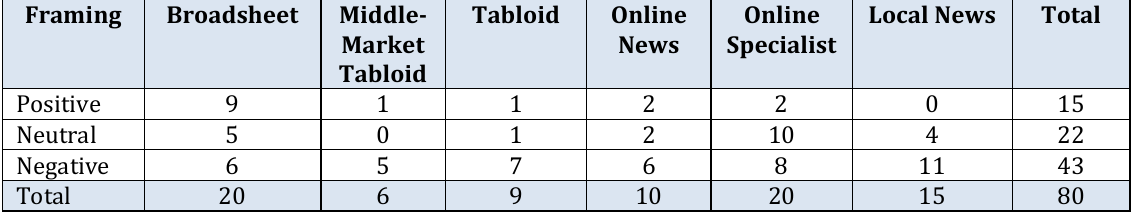
Table 1: Media Framing of the Lush Campaign